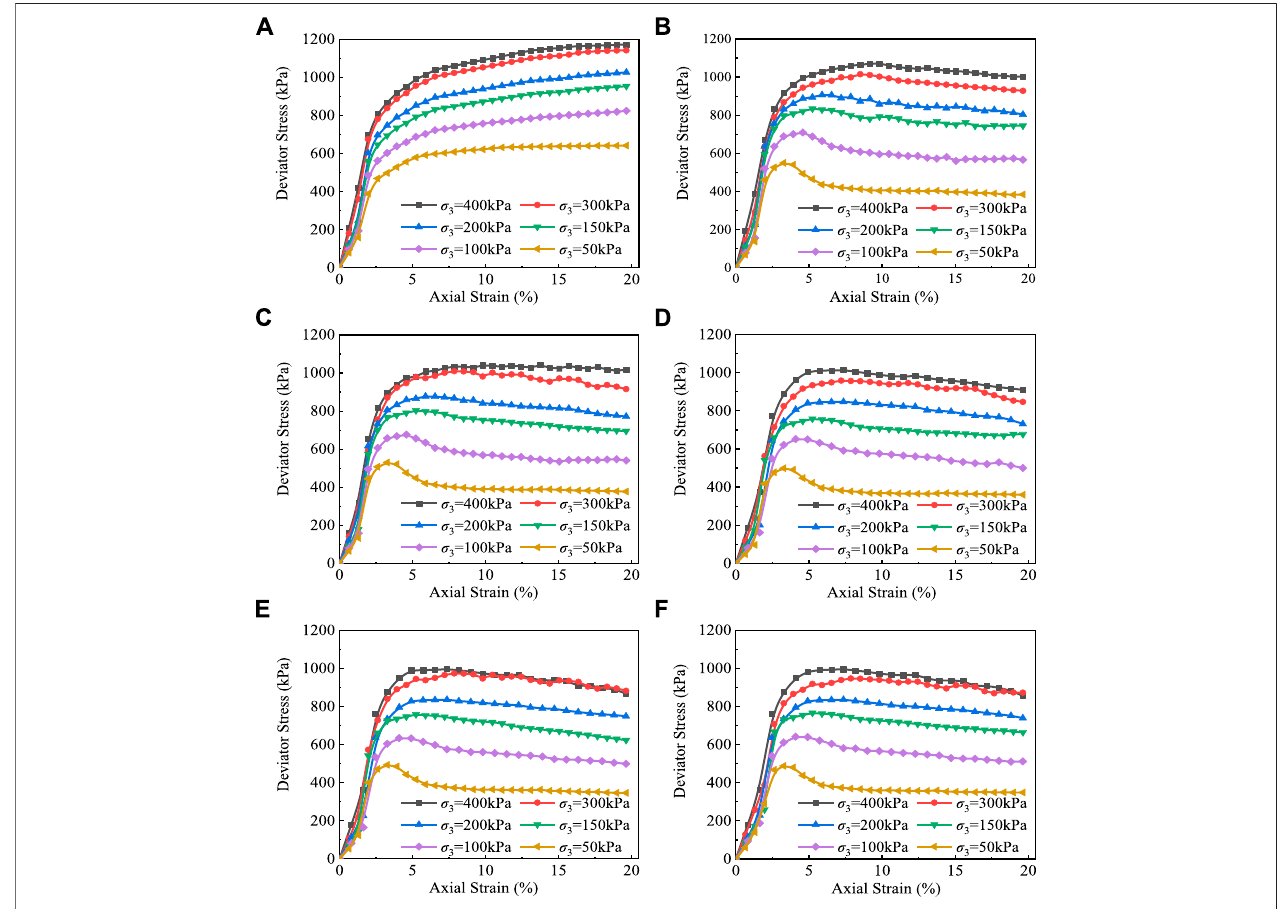
FIGURE3| Stress-strain curves ofthetested claysuffering fromvariousFTcycles. (A) 0FT cycle. (B) 1FTcycle. (C) 3FTcycles. (D) 6FT cycles. (E) 10FT cycles. (F) 15 FT cycles.